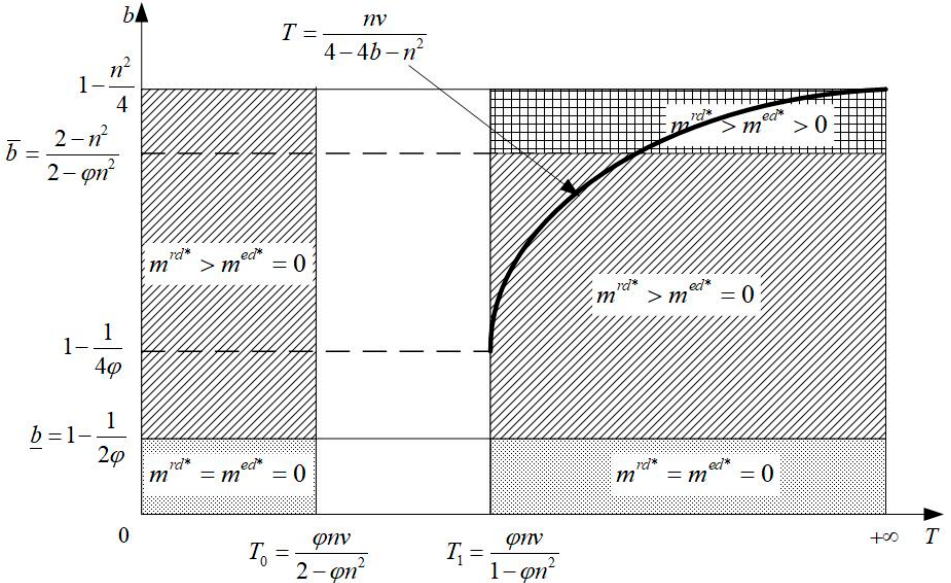
Figure 3. Optimal sales subsidy under different power structures.